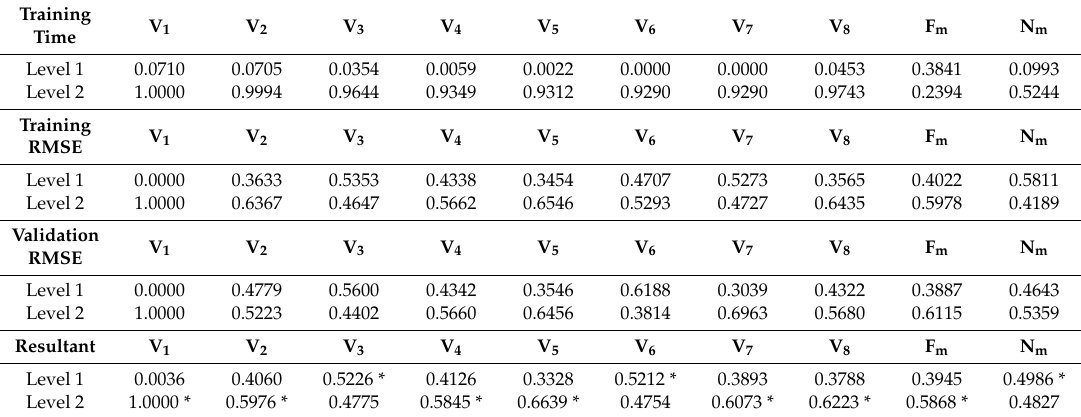
Table 4. Weight normalization and combination for demand forecasting. Table 5. Weight normalization and combination for electricity consumption forecasting.